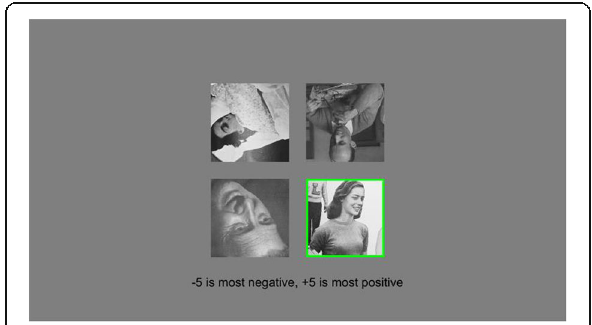
Fig. 3 Example trial from Part II. Participants saw an upright image that was cued after 1 second along with inverted distractor images